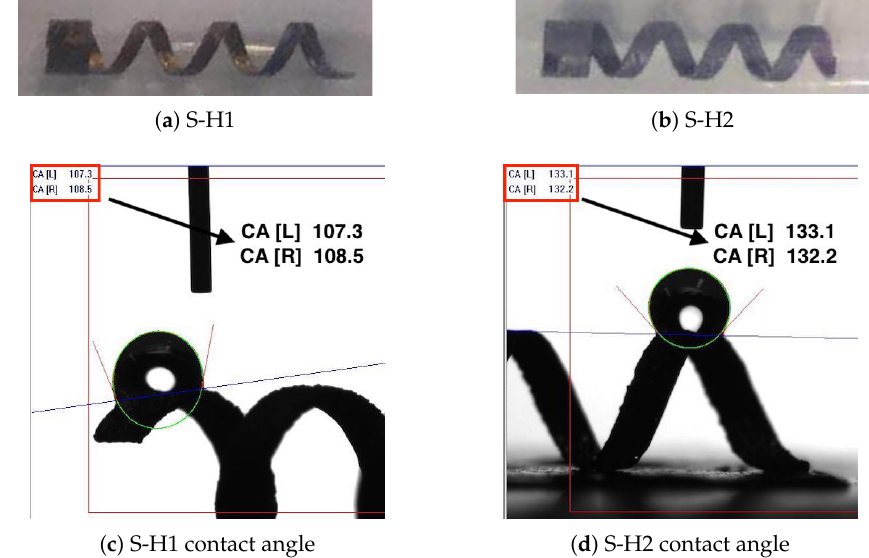
Figure 3. ( a ) S-H1: helical swimmer with less hydrophobic surface; ( b ) S-H2: helical swimmer